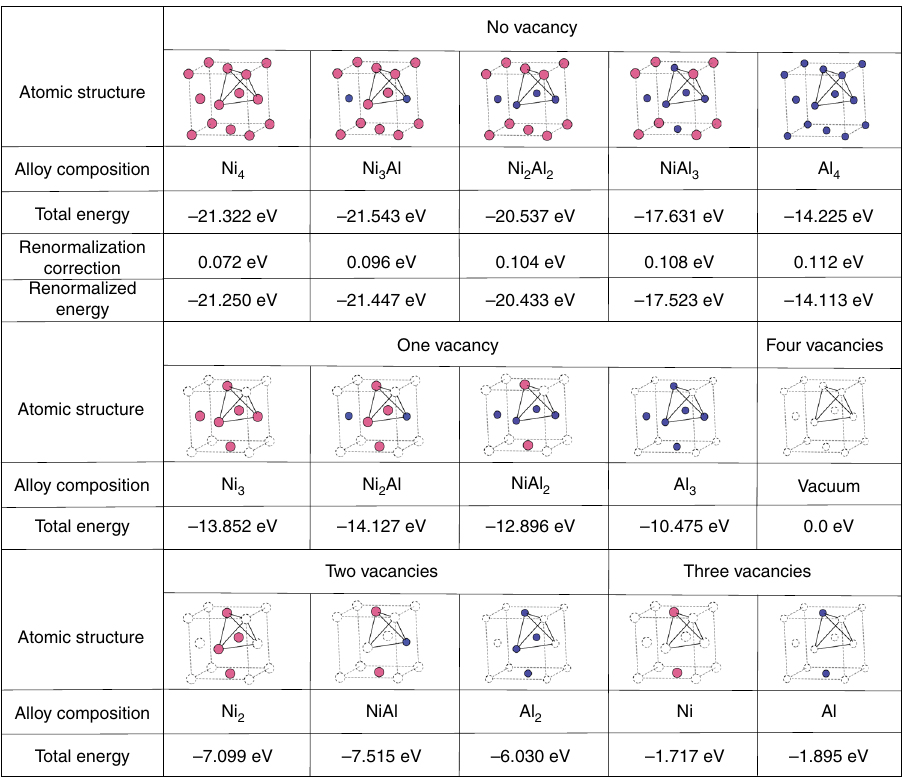
Fig. 2 Possible clusters and their energies in the cluster expansion theory (fcc lattice). Tetrahedral clusters with all the possible non equivalent combinations of Ni and Al, including vacancies at the lattice sites in a cubic unit cell. The total energies, calculated by ab initio DFT, renormalization corrections at T = 1300 K and the renormalized energies are shown below each structure of the no vacancy clusters, respectively. For the clusters with vacancy, total energies are shown. The Ni and Al atoms are represented by magenta and blue circles, while for vacancy cites white circles with dotted line are